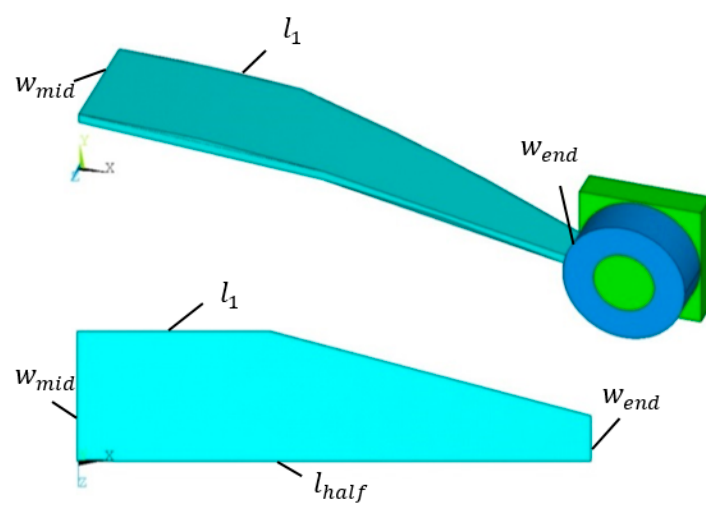
Figure 6. The model for the changed section width of sheet l 1 and w end as the design variable.